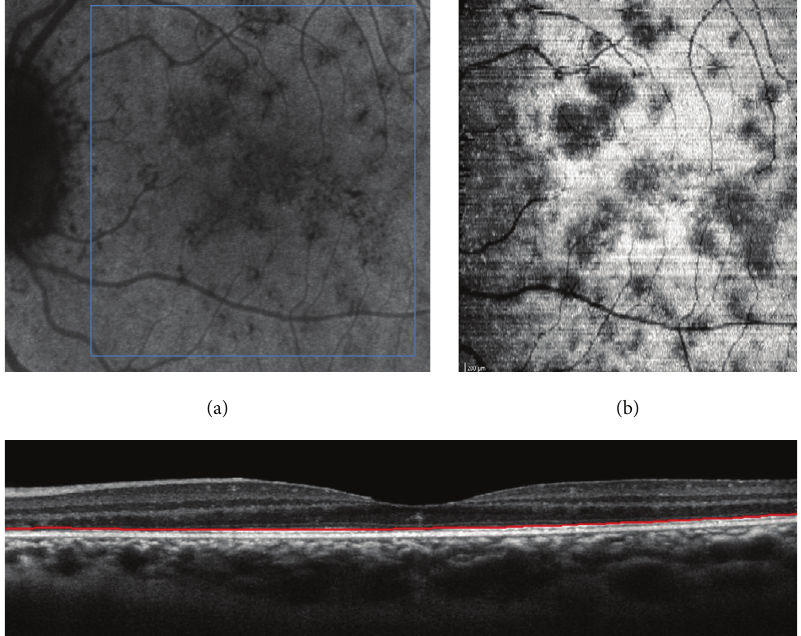
Figure 4: (a) Indocyanine green angiography (ICGA) with hypofluorescent areas; (b) “en-face” EDI SD-OCT (enlarged view) at the level of the ellipsoid zone with hyporeflective areas that matched the hypofluorescent areas on